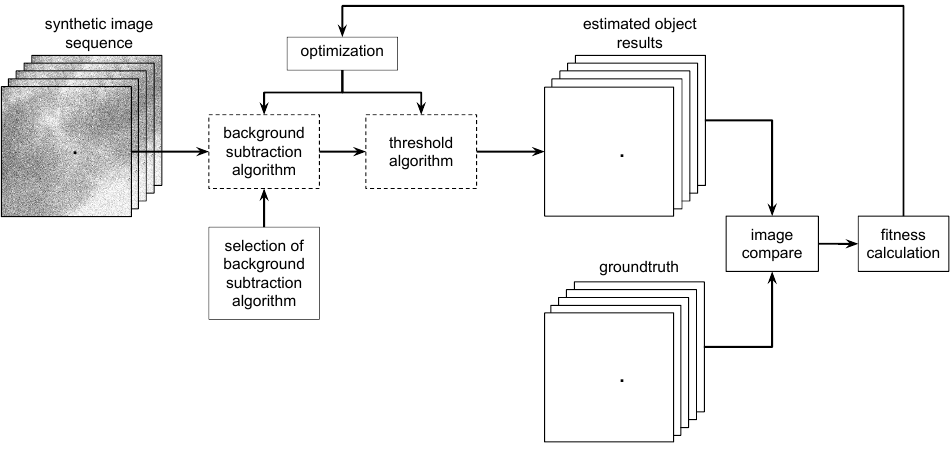
Figure 3. Background estimation pipeline and quality